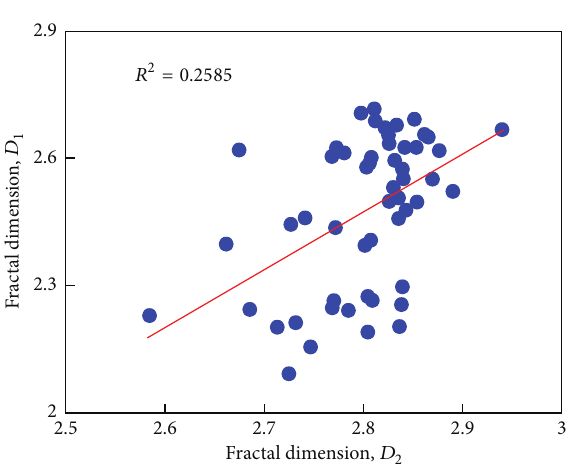
Figure 3: Relationship between fractal dimension 𝐷 1 and fractal dimension 𝐷 2